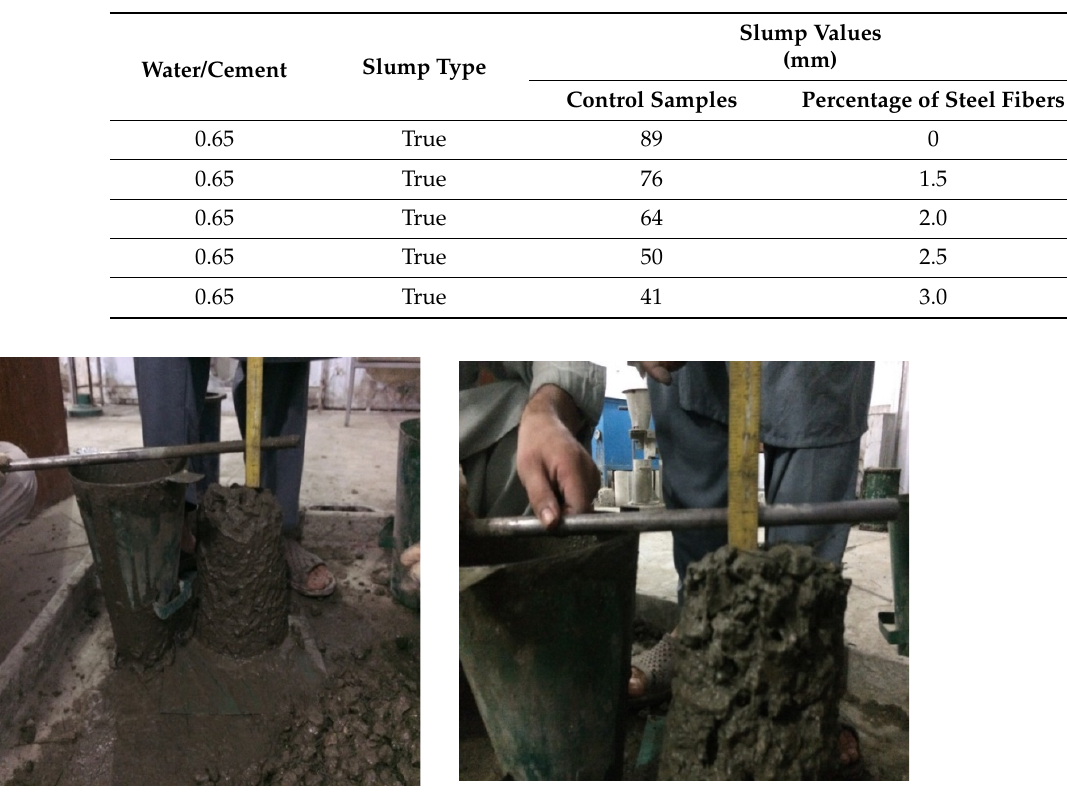
Figure 6. Slump cone test of fresh concrete.